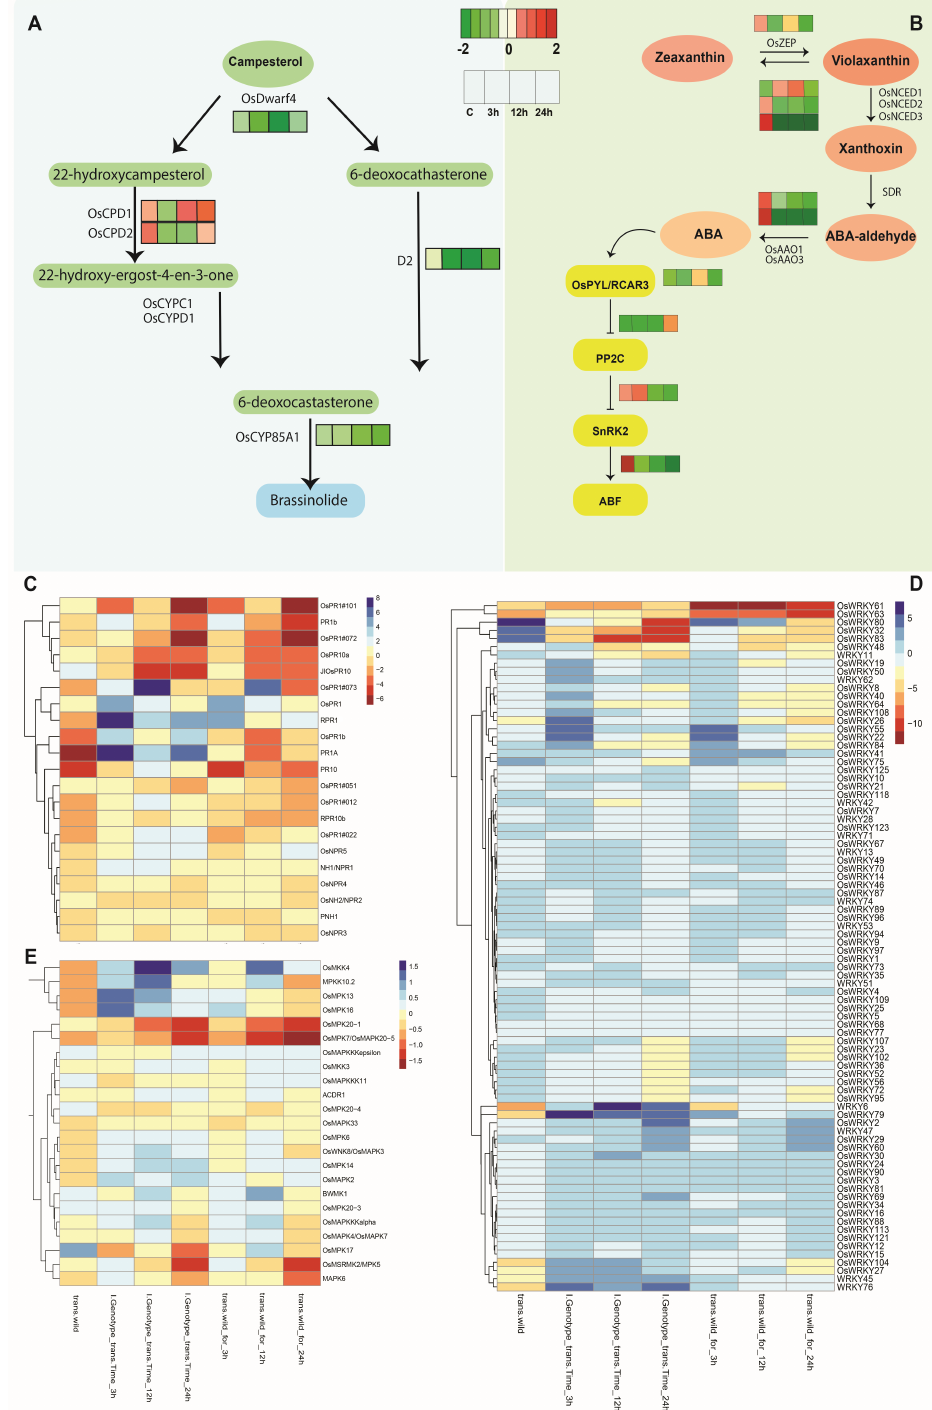
Figure 5. Transcriptional changes of abscisic acid and brassinosteroid biosynthesis pathway genes during white-backed planthopper infection in rice ( Oryza sativa ). ( A ) Abscisic acid biosynthesis and signaling genes; ( B ) brassinosteroid biosynthesis genes. Genes highlighted in red are upregulated, while those highlighted in green are downregulated in the RNA-seq dataset. ( C ) Heatmap shows the expression patterns of pathogenesis-related genes, ( D ) WRKY transcription factor, and ( E ) genes related to MAPK